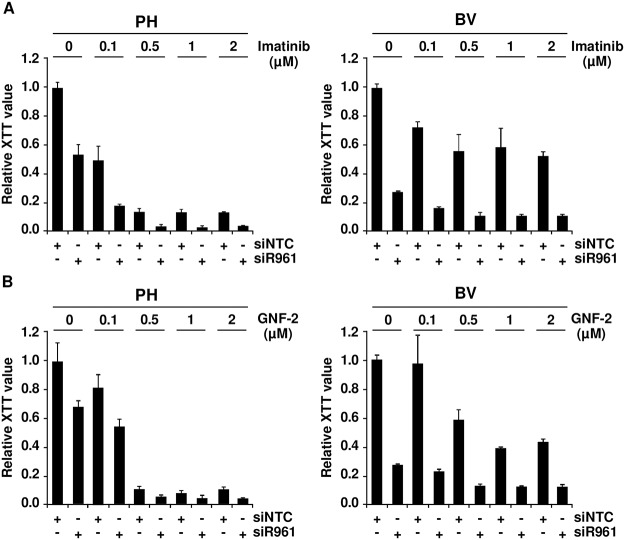
Role of p96ABL/BCR for response to selective TKI.PH and BV cells were transduced lentivirally with shRNAs against p96ABL/BCR; (A) Treatment with different concentrations of imatinib (0.1, 0.5, 1 and 2 μM). All experiments were performed in triplicates for a total of three experiments, which gave similar results. One representative experiment is given ± SD; (B) Treatment with different concentrations of GNF-2 (0.1, 0.5, 1 and 2 μM). All experiments were performed in triplicates for a total of three, all yielding similar results. One representative experiment is given ± SD.